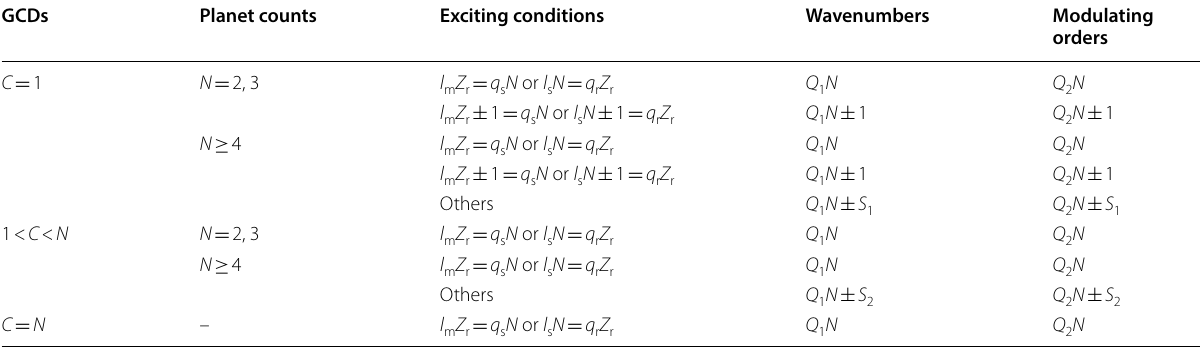
Table 7 Exciting conditions for elastic mesh and sideband